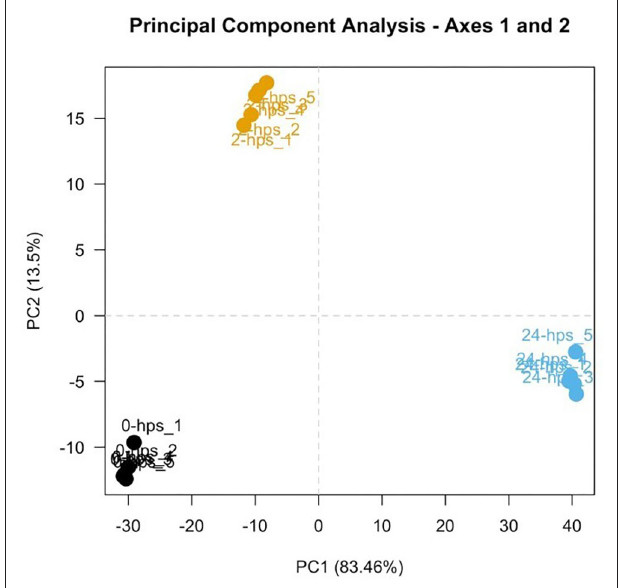
FIGURE 1 | First two components of a Principal Component Analysis, with percentages of variance associated with each axis. Five replicates of 0, 2, and 24-hps are represented in black, yellow, and blue dots, respectively.